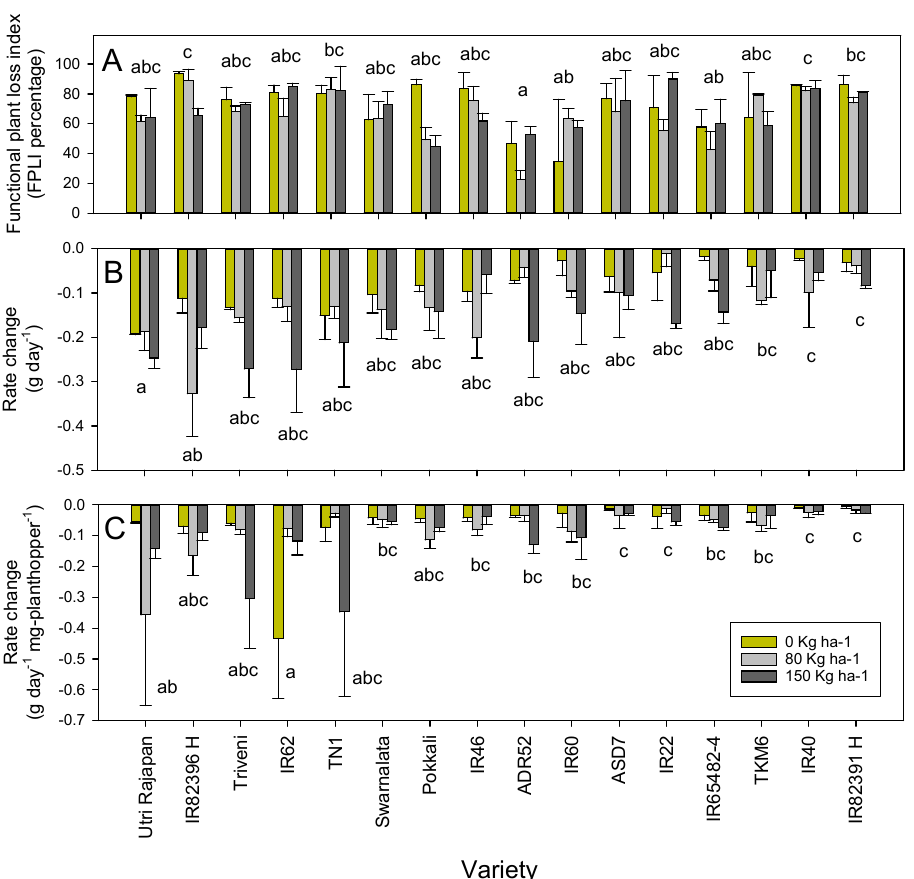
Figure 1. ( A ) FPLI for 16 varieties/lines at three nitrogen levels, with ( B ) changes in plant growth rate between 30 and 45 DAS under three levels of soil nitrogen after infestation with planthopper nymphs and ( C ) corresponding growth rate changes per mg of planthopper. Error bars are indicated (N = 3). Lowercase letters indicate homogenous variety groups (Tukey p > 0.05). Plant growth rates were reduced by planthopper feeding. The rate reductions were greater in Utri Rajapan and IR82396 H compared with IR40 and IR82391 H (F 15,94 = 3.665, p < 0.001: Figure 1B) and rate reductions increased under increasing nitrogen (F 2,94 = 10.130, p < 0.001, linear contrast = 0.001: Figure 1B). The plant growth rate reduction per mg of insect was greatest in IR62 and Utri Rajapan, and greater than reductions in IR22, IR40, IR82391 H, and ASD7 (F 15,96 = 1.992, p = 0.024: Figure 1C). Nitrogen did not affect the rate reductions per mg of insect (F 2,94 = 1.229, p = 0.297: Figure 1C). The interactions were not significant.